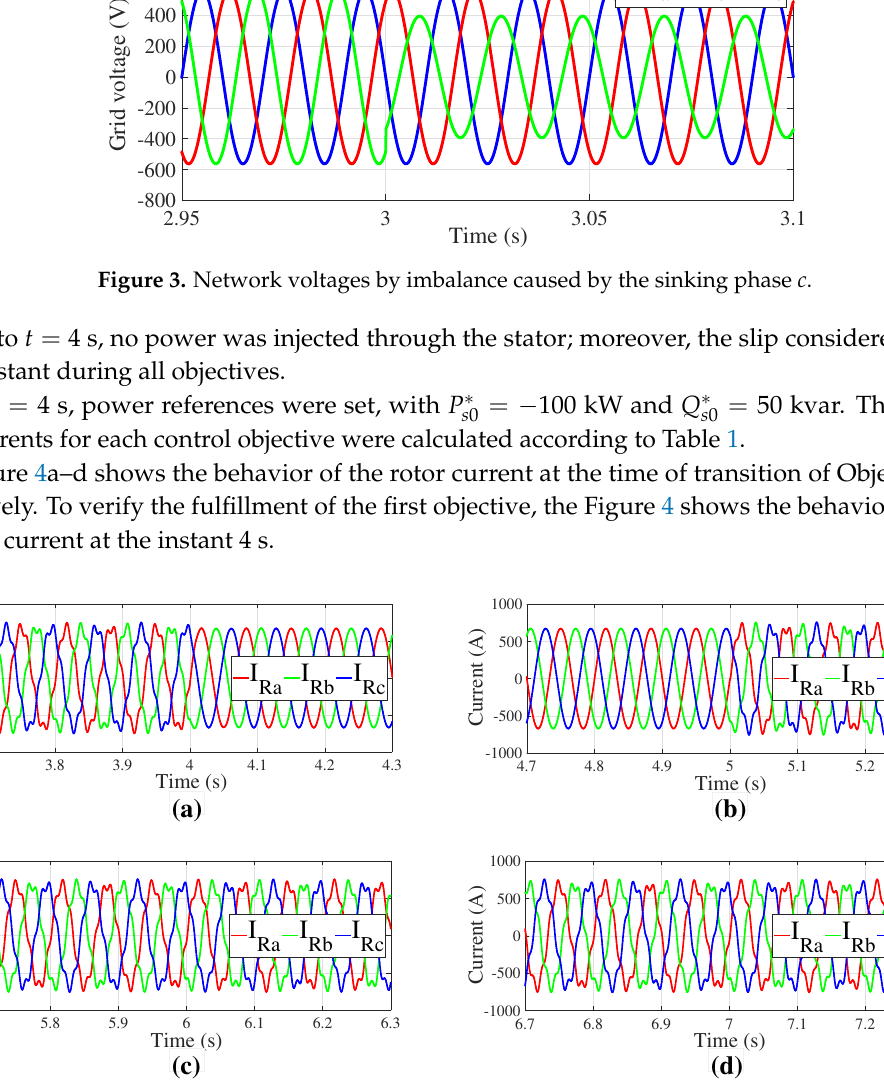
Figure 4. Evolution of the rotor currents (A) when changing from: ( a ) regular control